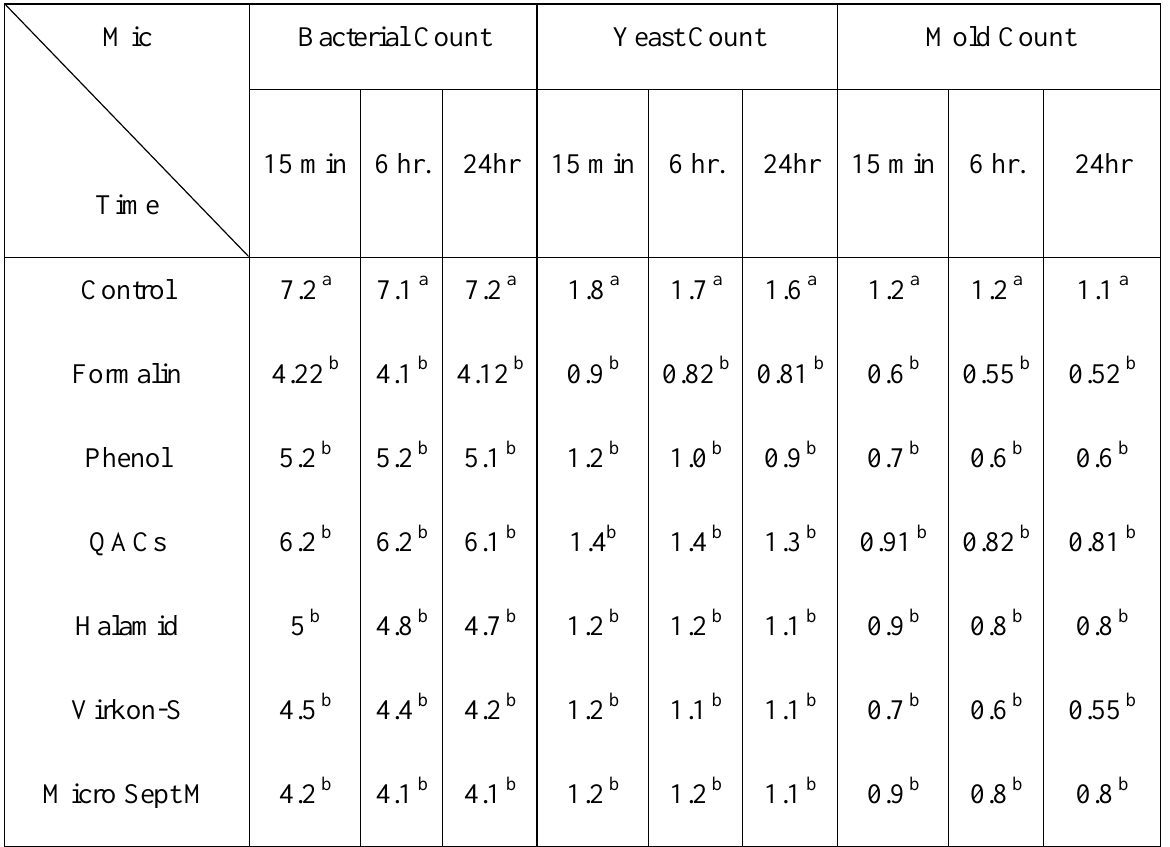
Table 3: The effect of high application level and contact time on total aerobic bacteria, yeast, and molds: Mic Bacterial Count Yeast Count Mold Count